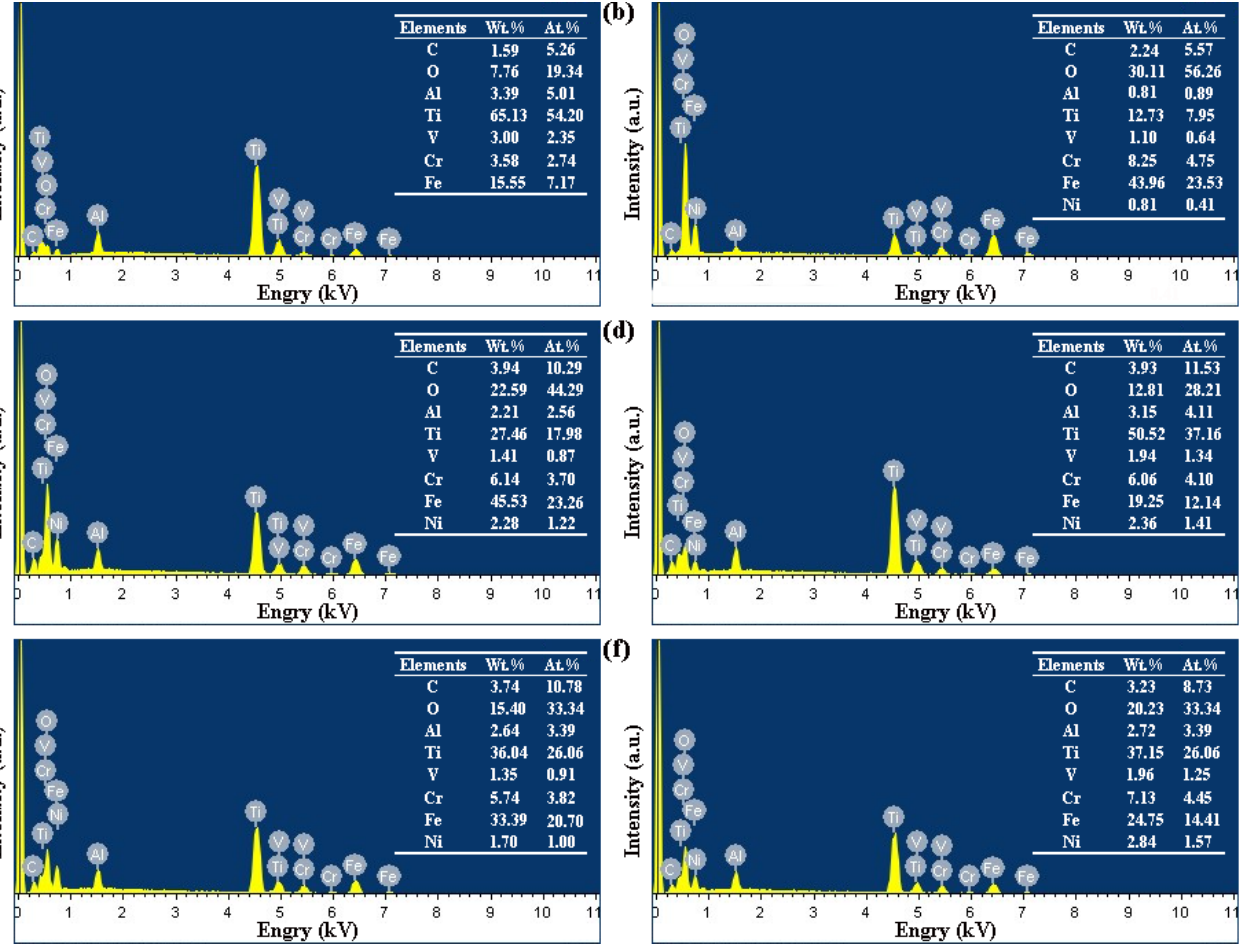
Figure 12. EDS spectra of wear debris of ( a ) the Ti6Al4V substrate and composite coatings with various CeO 2 contents: ( b ) 0 wt. %; ( c ) 1 wt.%; ( d ) 2 wt.%; ( e ) 3 wt.%; ( f ) 4 wt.%.